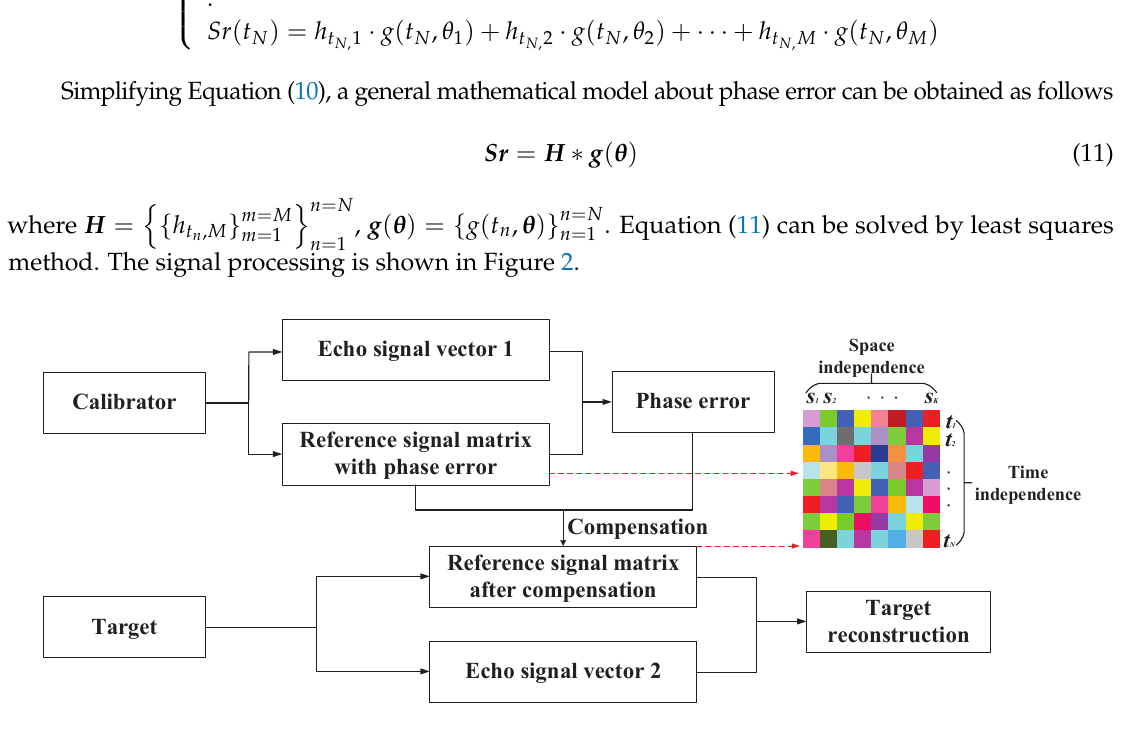
Figure 2. Signal processing of the Antenna Phase Error